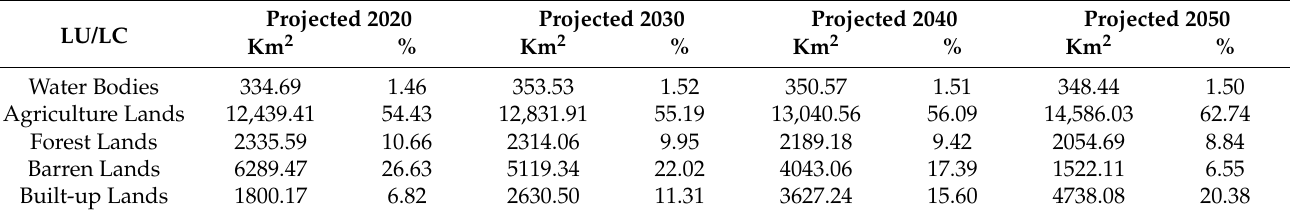
Table 4. Future projected LU/LC composition in the